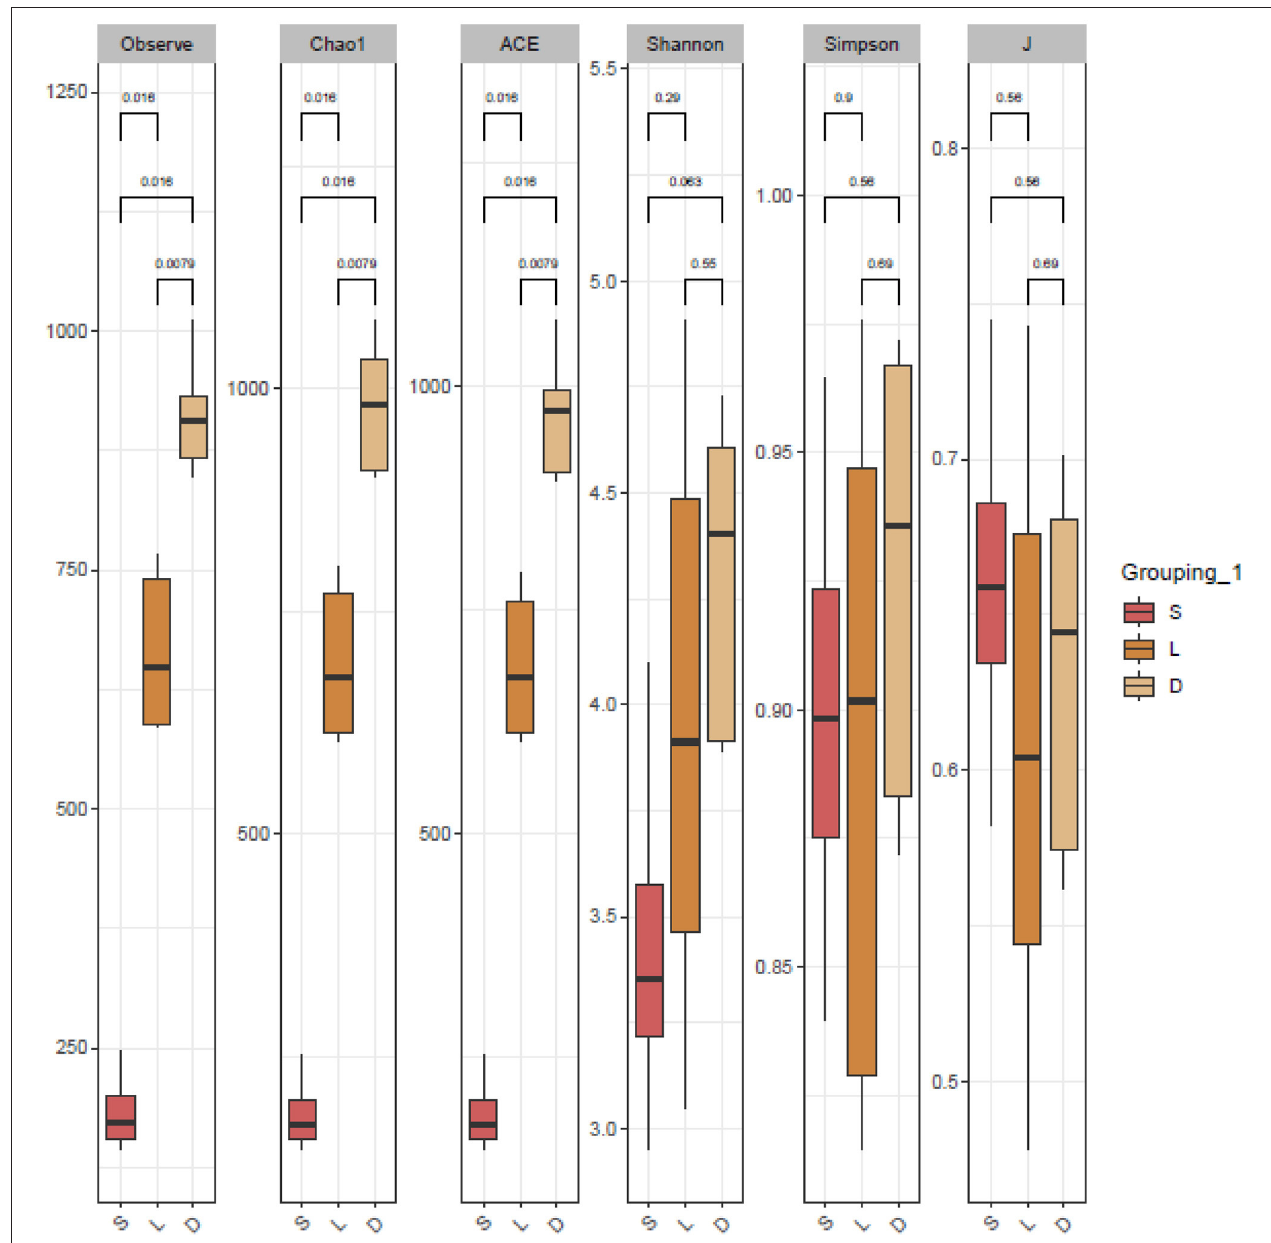
FIGURE 3 | Alpha diversity analysis of the dog gut microbial community. The richness and diversity estimators of observe, Chao1, ACE, Shannon, Simpson, and J indices were calculated, respectively. The observe, ACE, and Chao1 indices indicated that the bacterial richness of German Shepherd group was much higher than the other two groups, and Shannon and Simpson indices revealed that bacterial community diversity of German Shepherd was the highest.